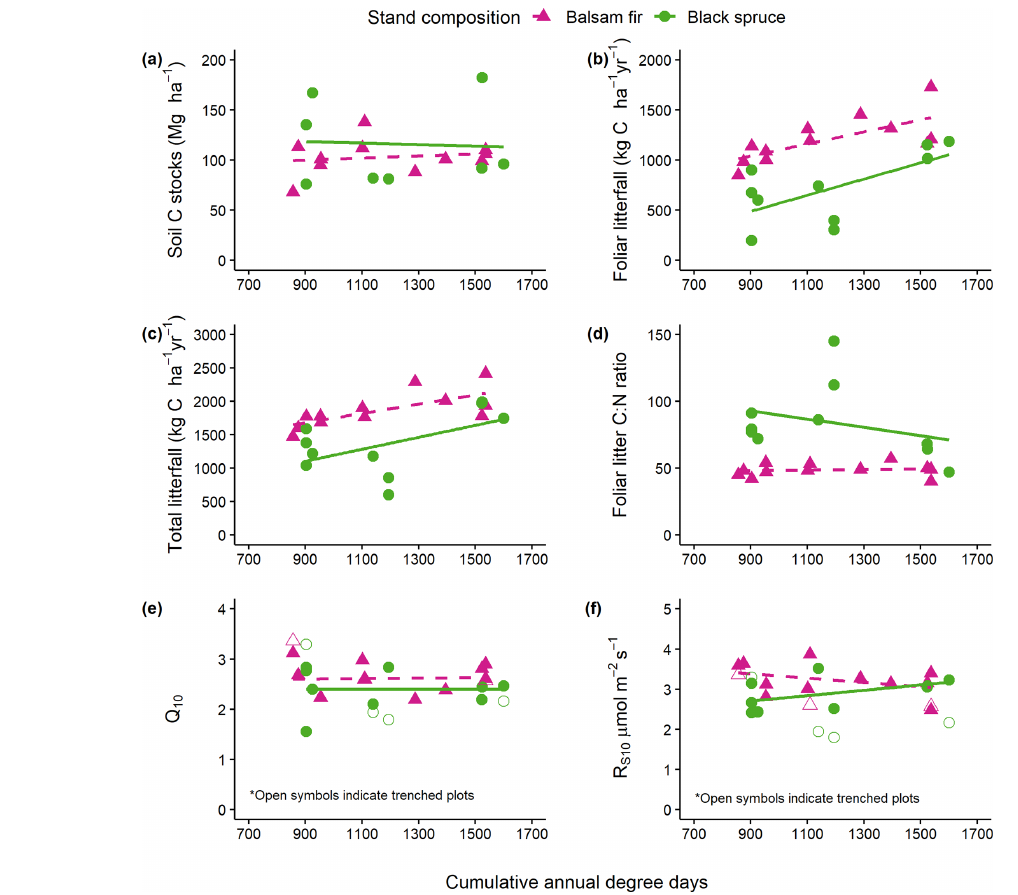
Figure 2. Relationships between degree-days (DD) and (a) soil carbon stocks (O.L. + top 0–20cm mineral soil) (b) , soil annual foliar litter- fall, (c) total annual aboveground litterfall, (d) foliar litter C:N ratio, (e) Q 10 and (f) R s 10 derived from field soil respiration measurements. Only the relationships with litterfall (b, c) were significant (see Table 3).